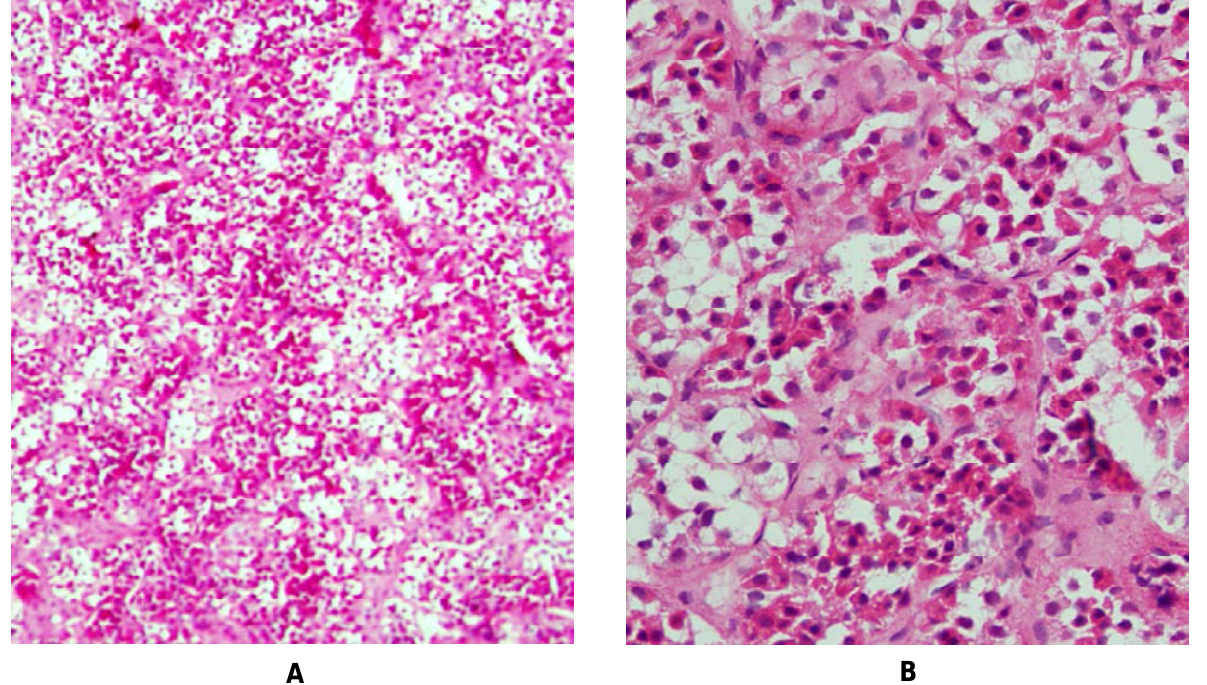
Figure 2. A - In low power field and B - In high power field: Demonstrating the tumour cells with round nuclei with finely dispersed chromatin, distinct nucleoli and eosinophilic granular